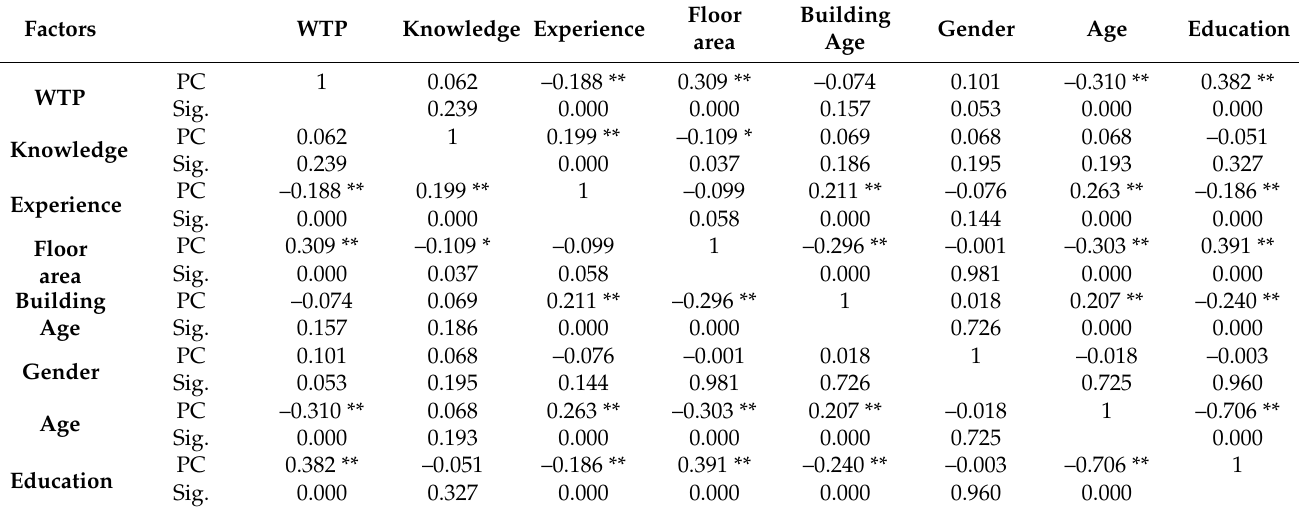
Table 2. Bivariate correlation analysis results of influencing factors and WTP.